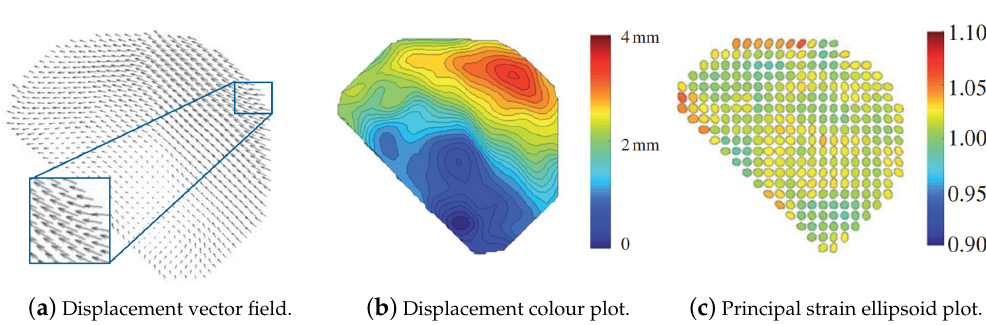
( a ) Displacement vector field. ( b ) Displacement colour plot. ( c ) Principal strain ellipsoid plot. Figure 8. Brain response to a mild frontal impact of subject S1 44.8 ms after the head is released into free-fall, extracted from Feng et al. [54]. ( a ) An example of the displacement vector fields published, largely indicating the direction the brain is displaced relative to the skull. ( b ) Colour plot indicating the magnitude of the relative displacements. ( c ) Ellipsoid plot indicating the principal strain across the brain slice. The colour and degree of stretch in the ellipsoid (compared to a circle) indicate magnitude. The direction of the elongation of the ellipsoid denotes the vector along which the principal strain acts. These images show the response of subject S1. Similar images are provided by Feng et al. [54] for all three subjects (S1, S2, S3) 39.2, 44.8, 50.4, 56.0 and 61.6 ms from the point of trigger release.